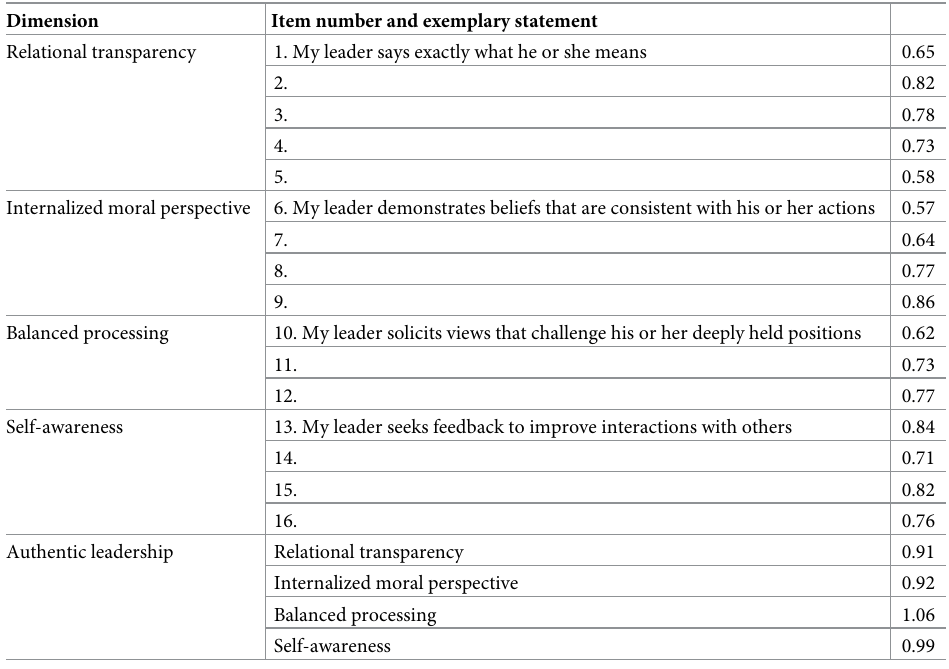
Table 4. Values of the factor loadings obtained via a confirmatory factor analysis of authentic